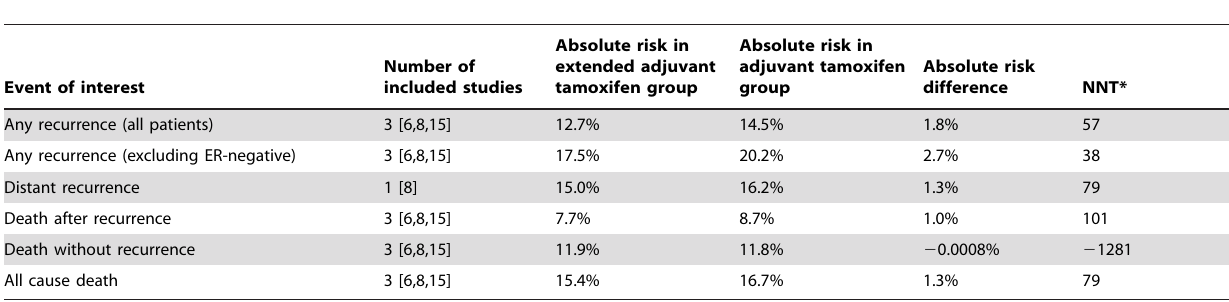
Table 2. Unweighted absolute risks and number needed to treat (NNT) for events of interest after 10 years of follow-up.